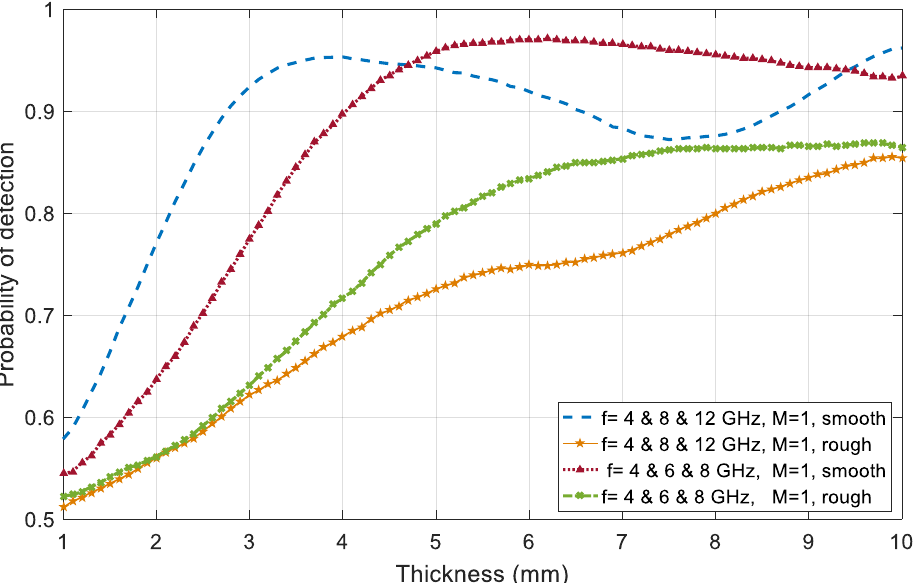
Figure 7. Comparison between the probability of detection versus the oil thickness (in mm) using different multi-frequency detectors for smooth and rough